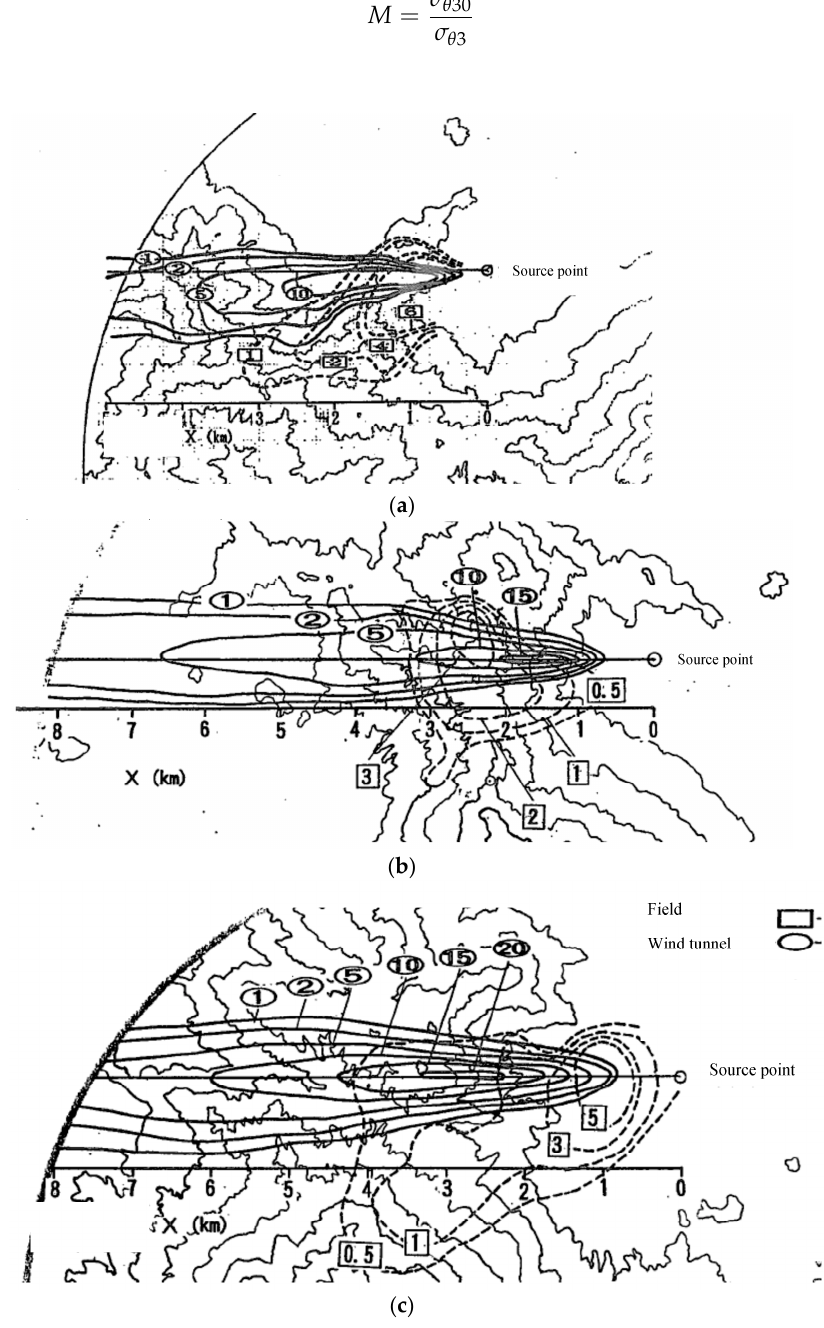
Figure 8. Comparison of concentration contour maps from the wind tunnel (solid lines) and field (dashed lines) [4], where numerical values indicate normalized concentrations, UC/Q (m − 2 ) × 10 6 . ( a ) Run No. 89-3 (Neutral: D); ( b ) Run No. 90-5 (Stable: F); ( c ) Run No. 90-8 (Unstable: B).